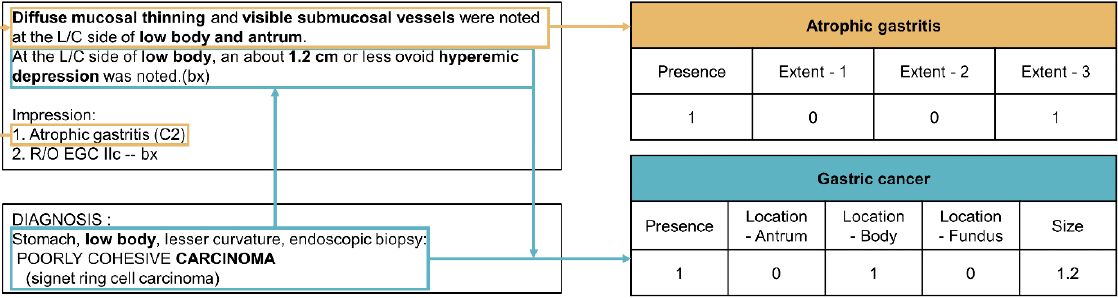
Figure 3. Example of extraction and summarization process of the NLP pipeline. Extent — 1: antrum only; Extent — 2: body/fundus only; Extent — 3: antrum and body/fundus; NLP: natural language processing.